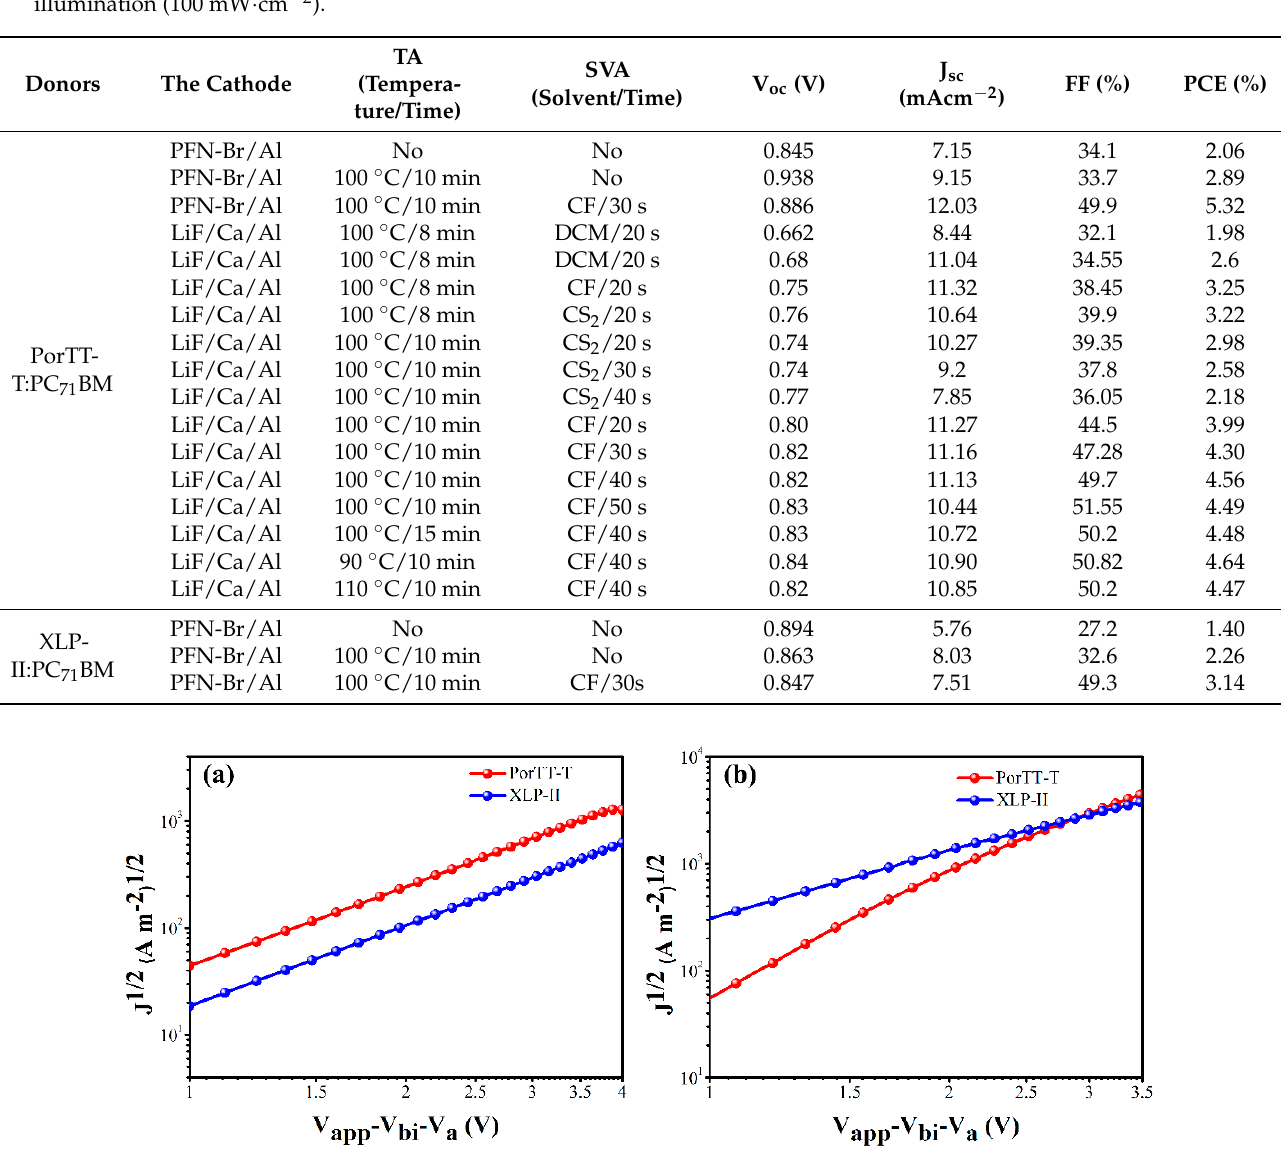
Figure 7. Mobility of excited charge carriers of PorTT-T and XLP-II. ( a ) Hole transport for an ITO/ZnO/D:A/PFN-Br/Al device and ( b ) electron transport for an ITO/PEDOT/D:A/MoO 3 /Al device.